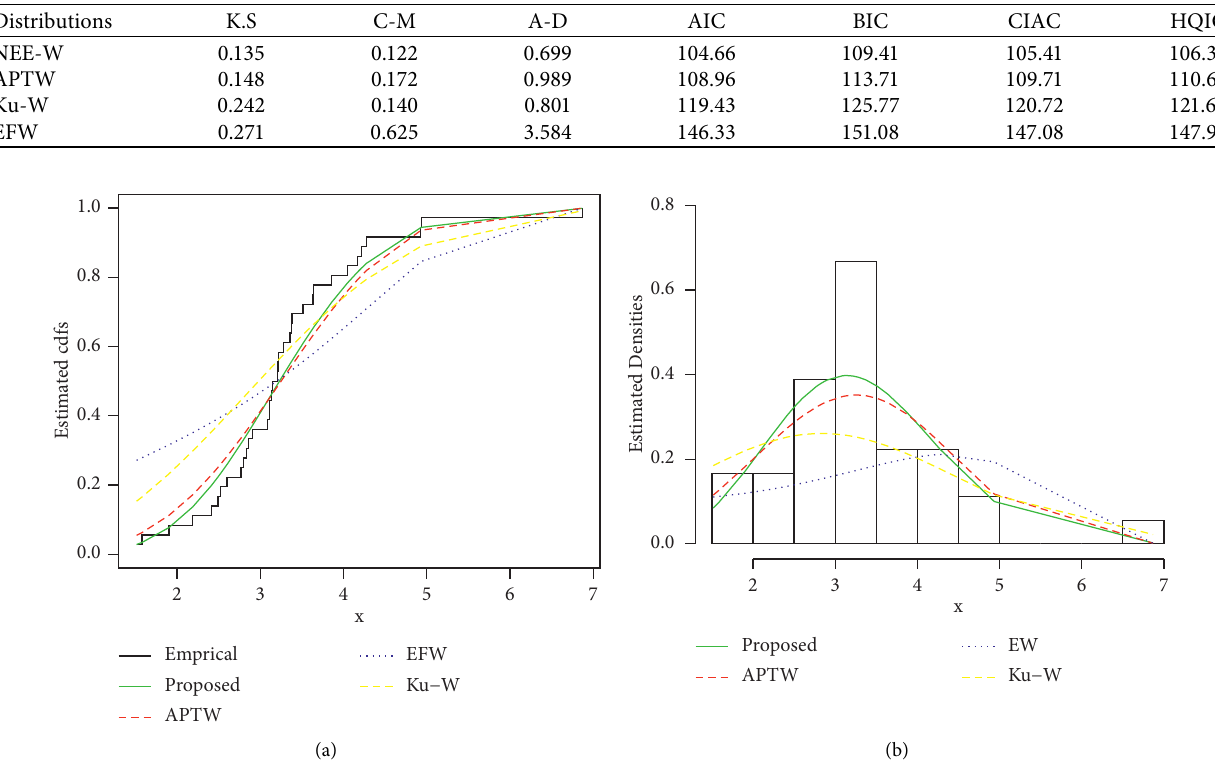
Table 4: The numerical results of Canadian COVID-19 data for the proposed and competing models.